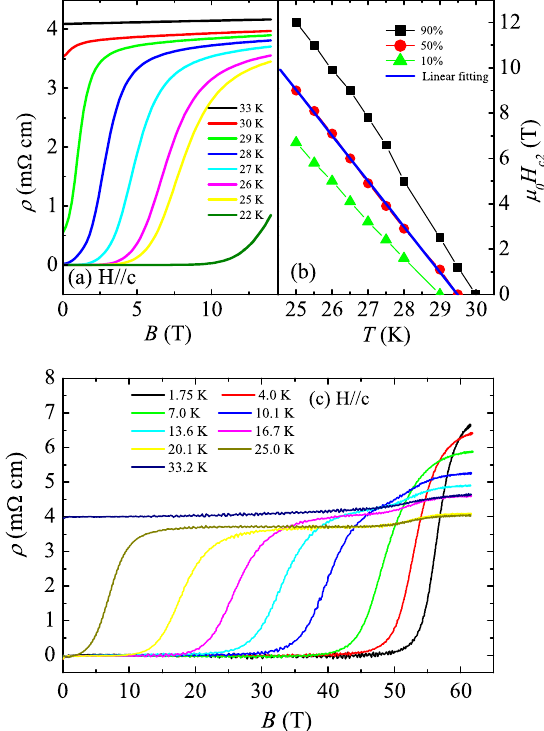
FIG. 2. Field dependence of the in-plane resistivity in a K 0 Fe 1 Se 1 Te 0 single crystal with a magnetic field ap- . 70 . 46 . 85 . 15 plied parallel to the c axis at fixed temperatures. (a) The resistivity data for temperatures between 22 and about 33 K up to 14 T. (b) Temperature dependence of μ 0 H c 2 ð T Þ near zero-field T c for the Te-doped crystal with H ∥ c using different criteria in the resistive transition shown in (a). (c) Resistivity data for temper- atures between 1.75 and 33 K in pulsed fields up to 60 T.